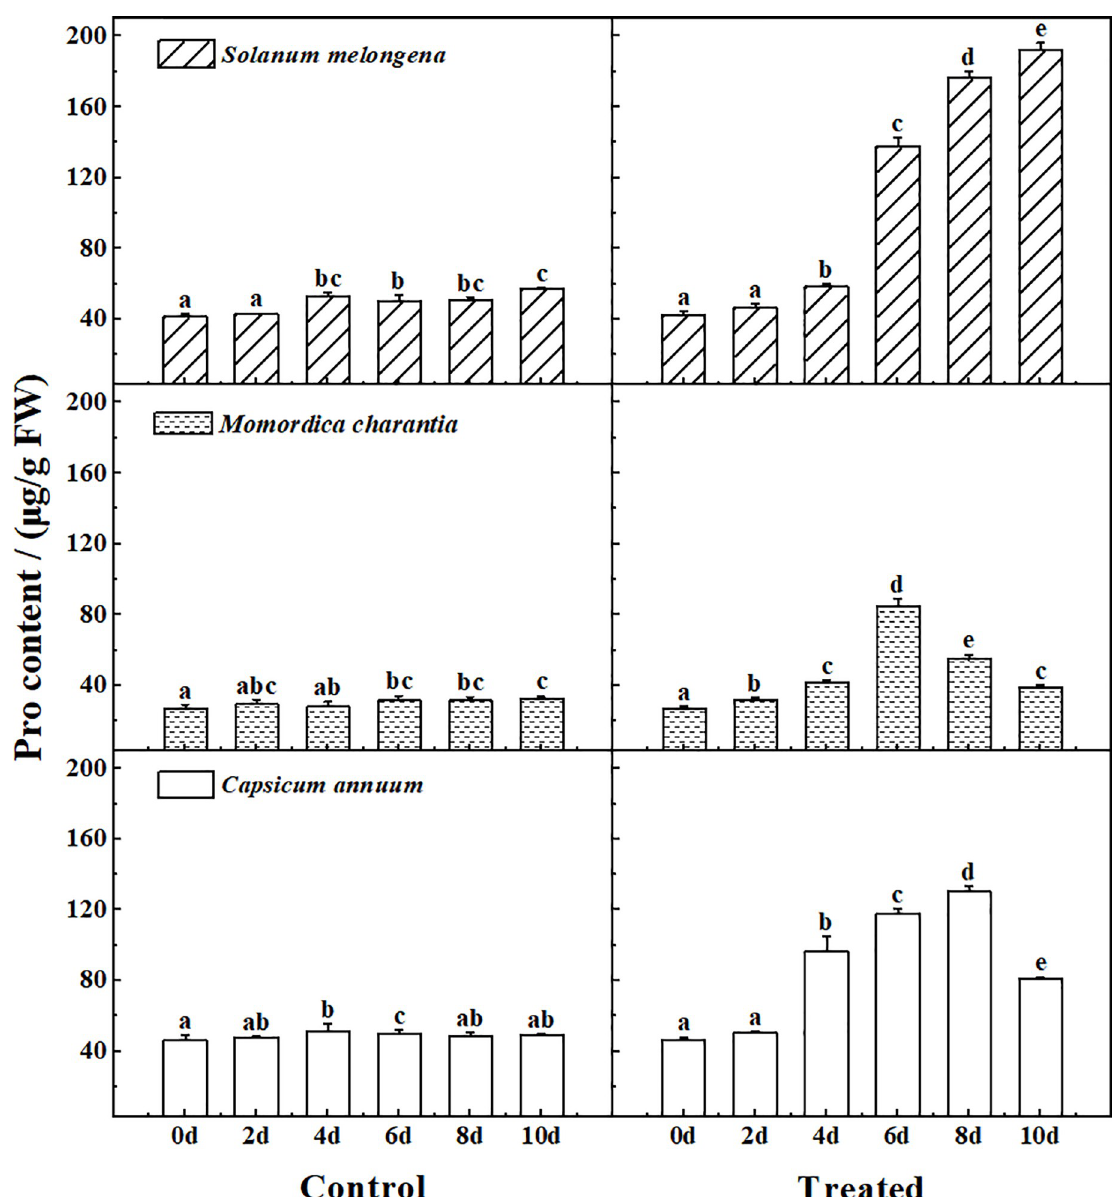
Fig 3. The response of proline (Pro) to normal watering (Control) and salt water irrigation (Treated) in Solanum melongena , Momordica charantia , Capsicum annuum . The single salt solution (NaCl, 150 mmol/L) was watered once a day (25 ml per pot) for a total of 10 days, seedling leaves were randomly sampled every 2 days to determine Pro. Error bars represent standard errors of Pro with 4–5 replicates measurements. The same letter in each picture represents no significant difference (Duncan test, P < 0.05, n =